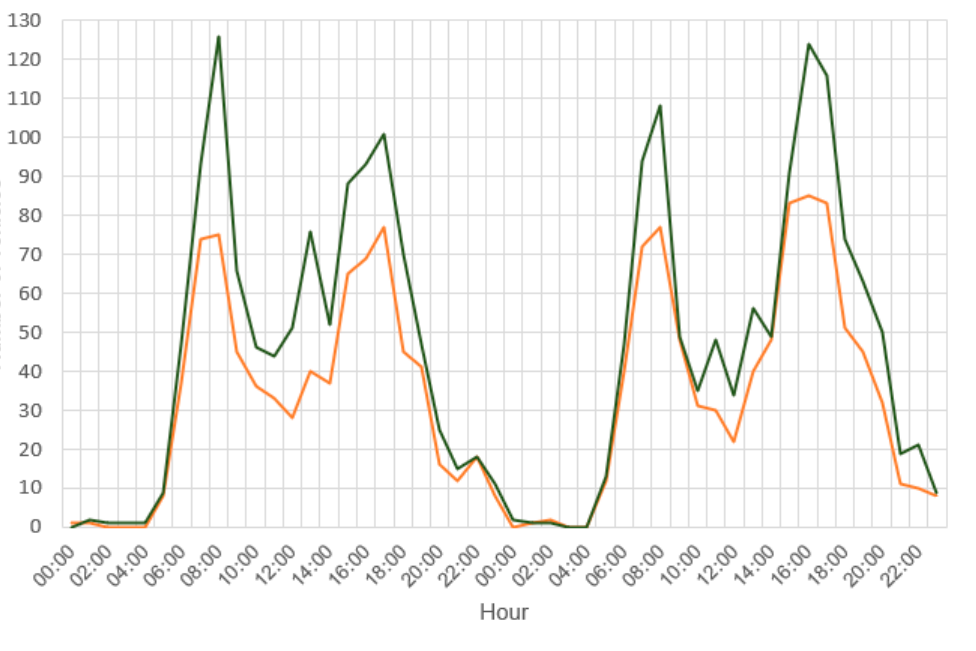
Figure 7. Comparison of the number of vehicles recorded by the perpendicular radar with the actual number of bicycles (own study).